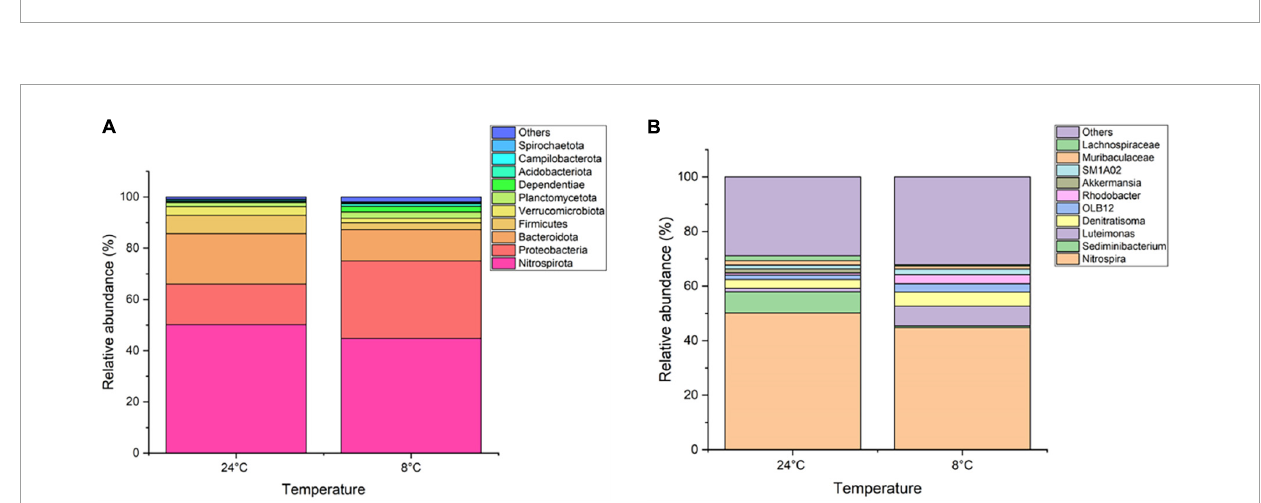
FIGURE3 (A) Alpha biodiversity indicating species rarefaction curve and (B) beta biodiversity heat map (upper and lower values represent the unweighted and weighted Unifrac distance) of biomass samples from the MABR. E3 and E4 are duplicate samples taken at 24 ◦ C, F3 and F4 are duplicate samples taken at 8 ◦ C.